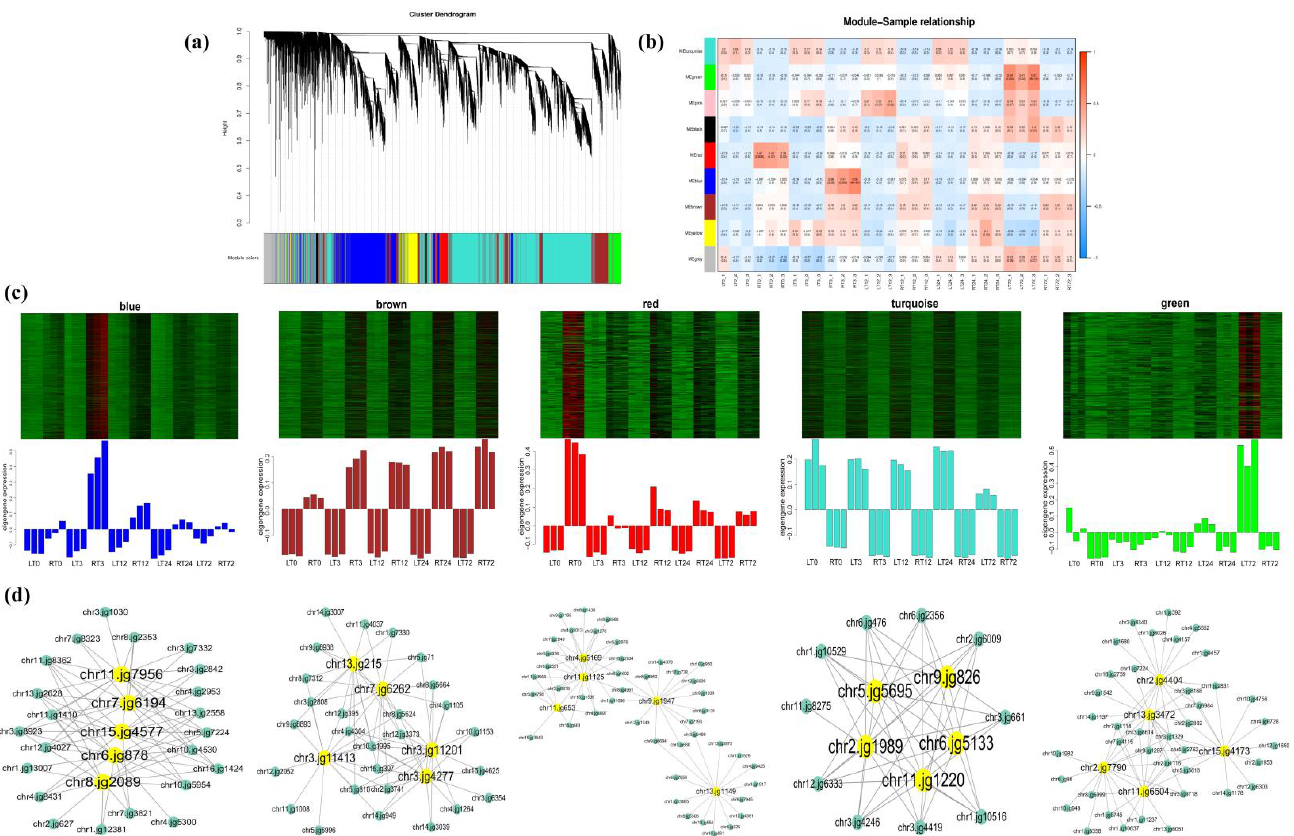
Figure 7. Weighted gene co-expression network (WGCNA) analysis of DEGs of T. repens under Cd treatment. ( a ) Cluster dendrogram of 9 different expression modules; ( b ) module-sample relationship; ( c ) expression levels of genes among five selected modules most significantly correlated with roots and leaves under Cd stress; ( d ) the correlation networks of hub genes of the DEGs corresponding to the modules in WGCNA, the Kwithin value was showed in Table S3.